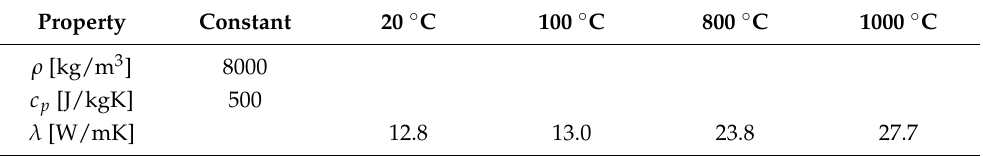
Table 3. Material properties for 1.4857